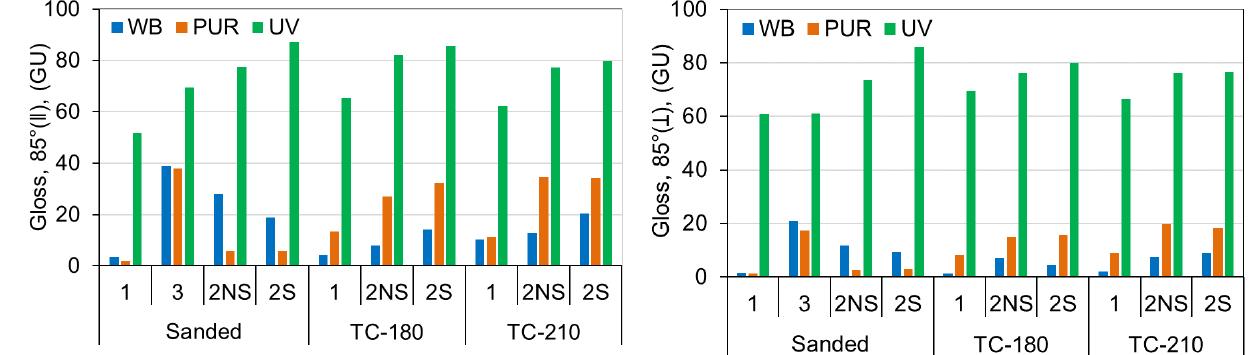
Figure 1. Impact of varnish type, number of varnish layers and method of pre-treatment on the gloss values of alder varnished surfaces along and across the fibers; (WB — water-based varnish, PUR — polyurethane varnish, UV — UV-cured varnish).